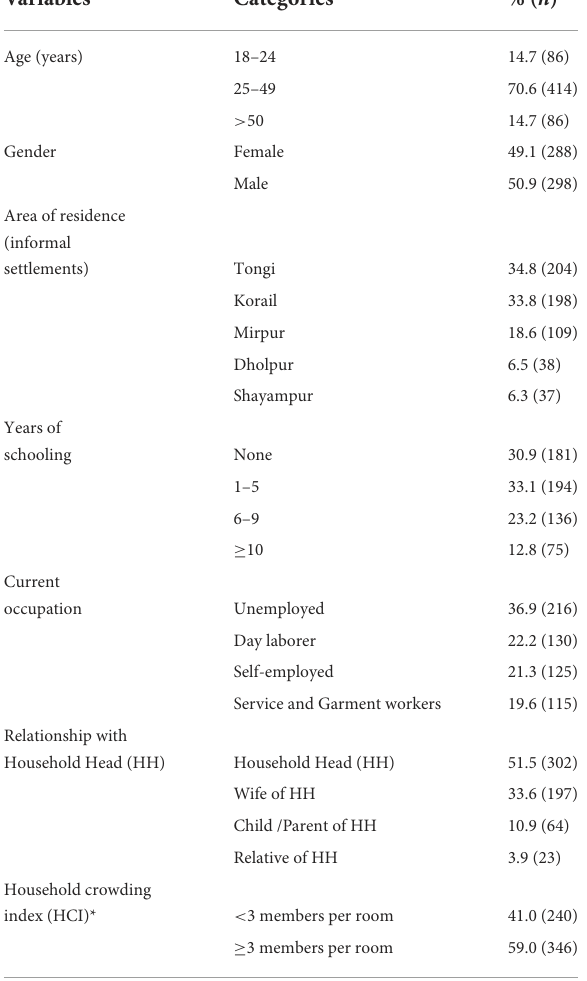
TABLE 1 Characteristics of the low-income urban households ( n = 586) during the first wave of the COVID-19 pandemic in